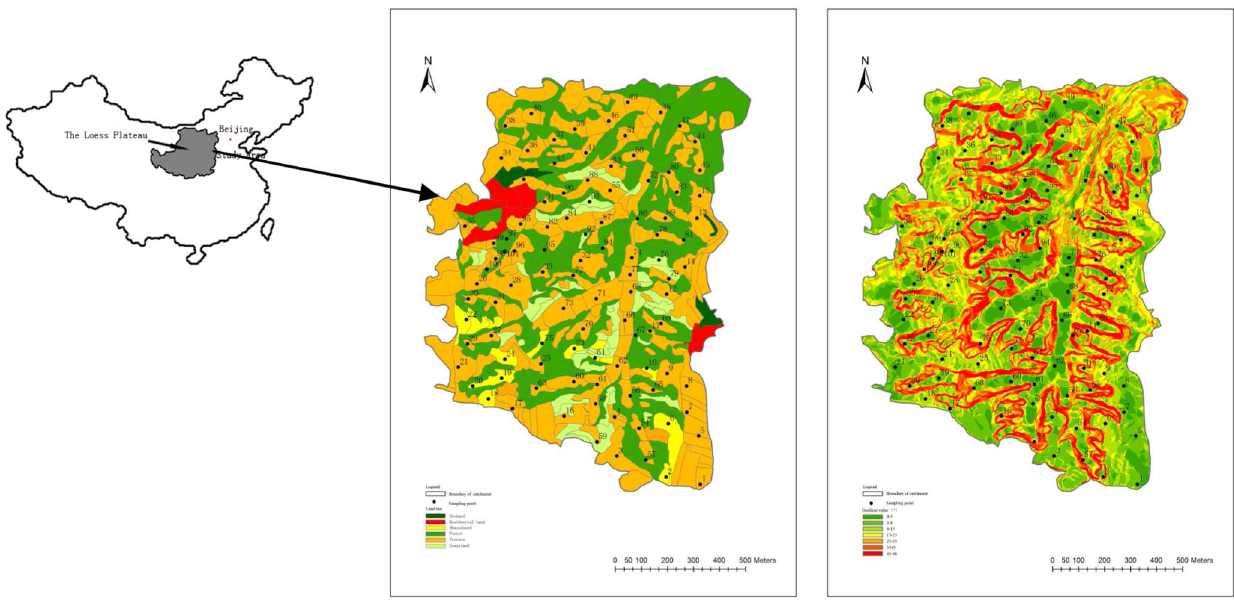
Figure 1. Location of Sanyanjing catchment and distribution of 101 sampling points in the Sanyanjing catchment.